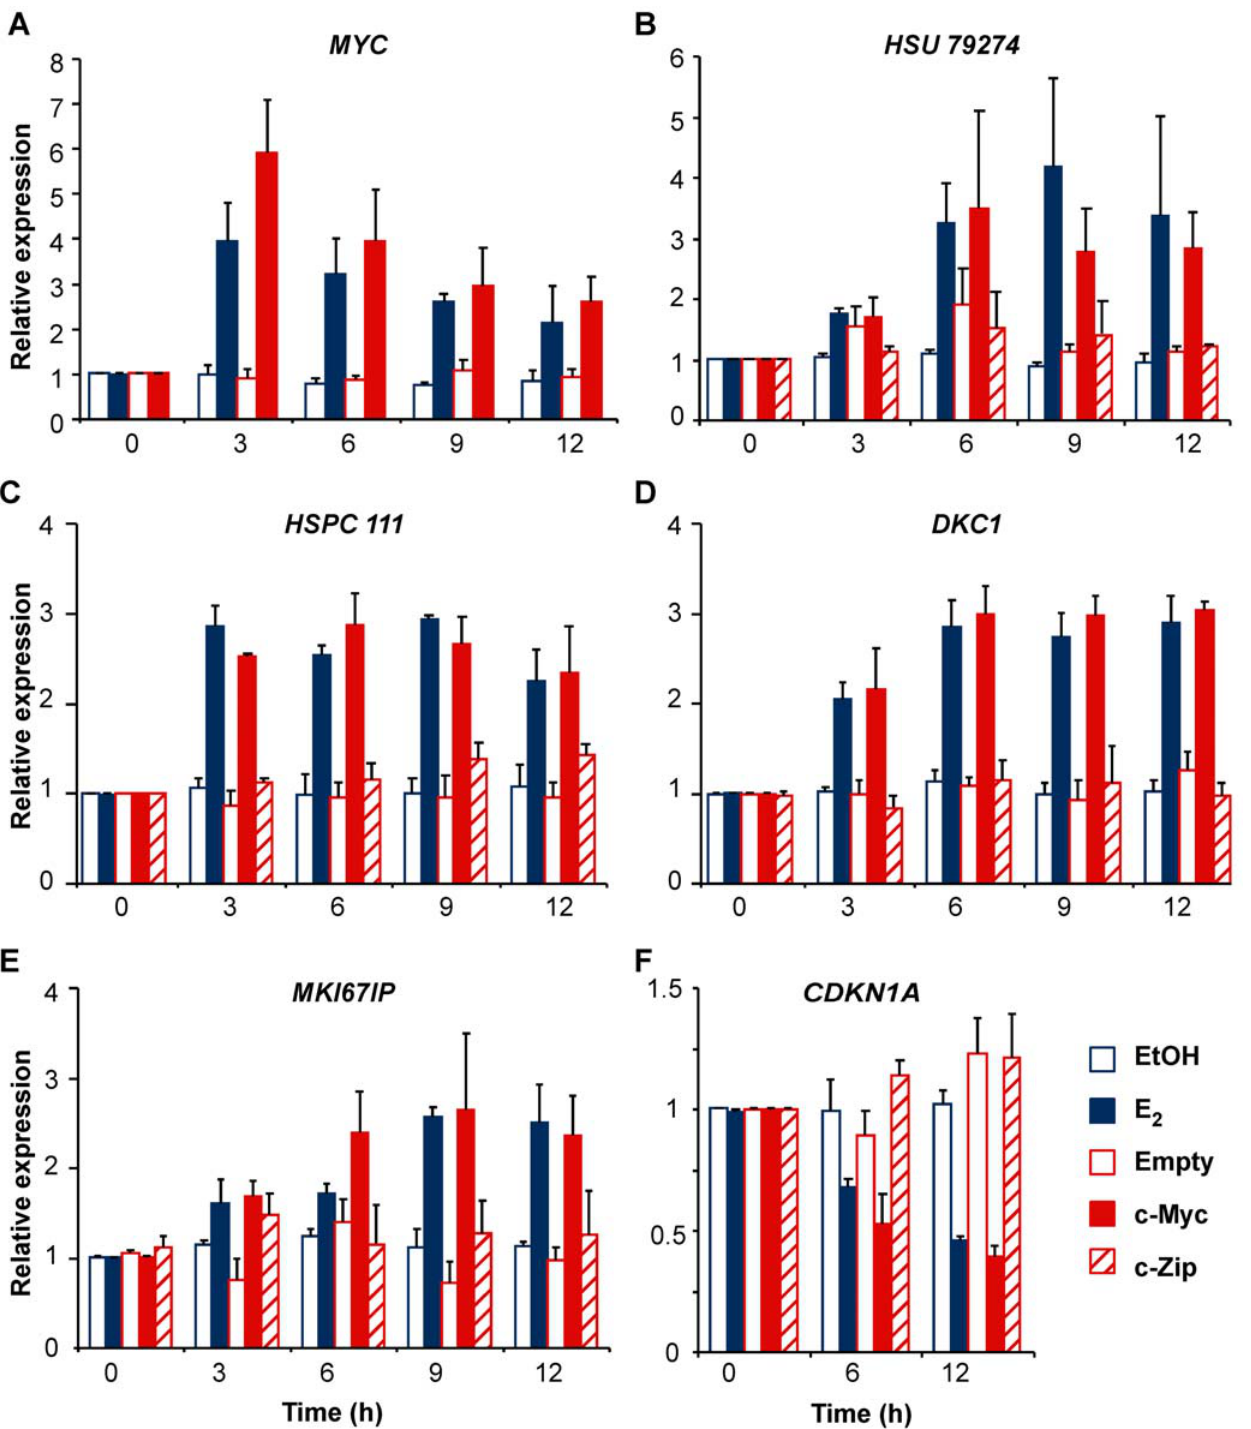
Figure 3. Estrogen and c-Myc regulation of selected genes. The experimental design is described in Fig. 1. For the indicated genes, mRNA levels were quantitated by qRT-PCR and are presented as the mean 6 range or SEM of 2–3 experiments. EtOH, E 2 , Empty and c-Myc data in (C) are redrawn from [18]. doi:10.1371/journal.pone.0002987.g003 (Fig. 2B–F). As a further test of the conclusion that these genes are most effective of the siRNAs tested, siMyc-17, reduced the estrogen regulated via an estrogen-mediated increase in c-Myc estrogen induction of c-Myc protein and mRNA at 6–9 h from , 5-fold to a statistically non-significant level of , 2-fold (Fig. 4A&B expression, MCF-7 human breast cancer cells were stimulated with E 2 in the presence of siRNAs directed at c-Myc (siMyc). The and data not shown). In the presence of siMyc, none of the genes